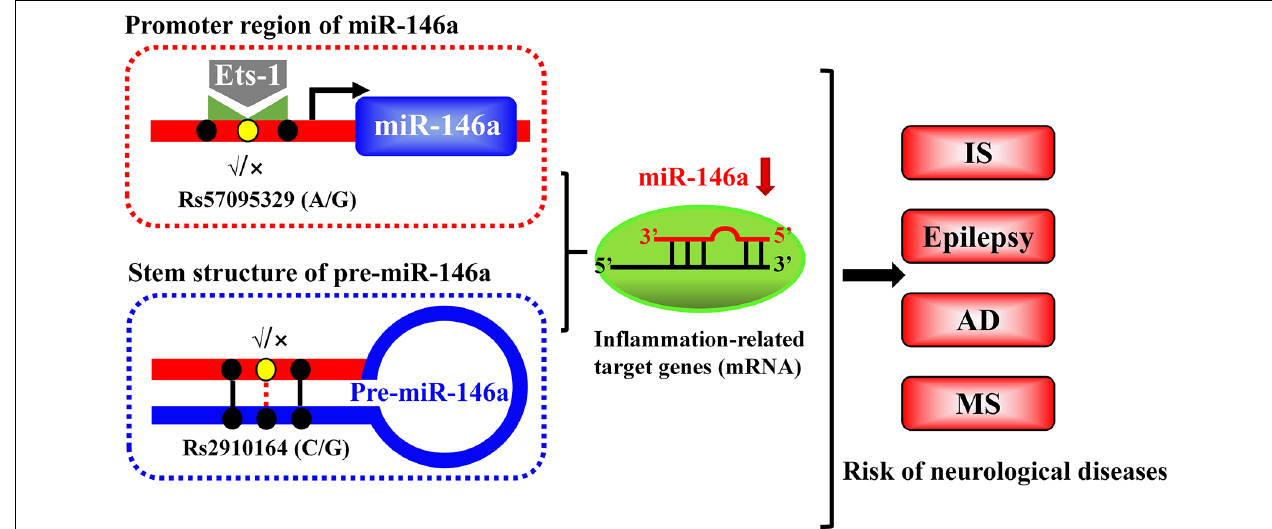
FIGURE 2 | Schematic illustration of the mechanism through which two single-nucleotide polymorphisms (SNPs) alter the expression of miR-146a. The rs2910164 polymorphism results in a mismatch in the stem region of pre-miR146a and influences the expression of mature miR-146a. Another polymorphism, rs57095329, is located in the promoter region of miR-146a and affects its availability and affinity for binding to Ets-1, thereby modulating its